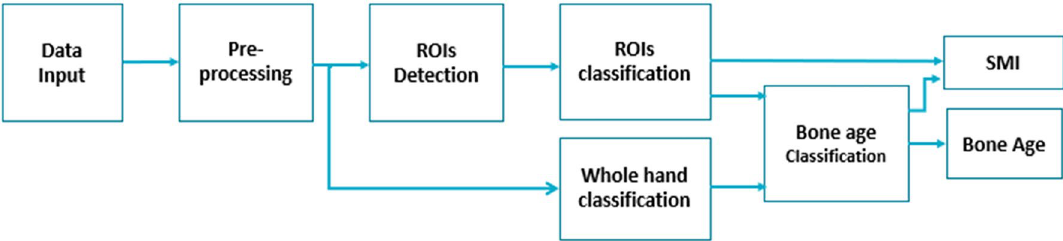
Figure 1. Overview of the steps involved in the modified SMI-based skeletal maturation assessment system. In the pre-processing step, the image size of hand-wrist radiographs is adjusted, and right-hand radiographs are mirrored. In addition to the detection and classification of each ROI, the evaluation of the whole hand as a holistic image is performed to enhance the performance by including maturity features that are not parts of the